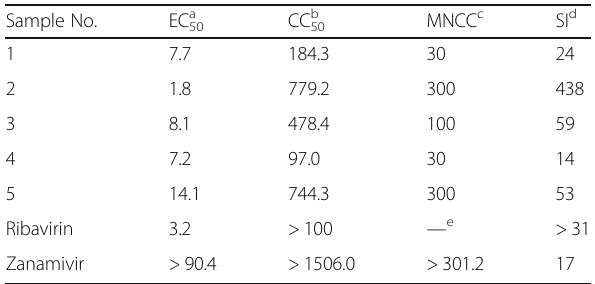
Table 2 Inhibitory activity of Chinese herbs extracts ( 1 – 5 ) on A(H1N1) influenza virus by CPE assay Sample